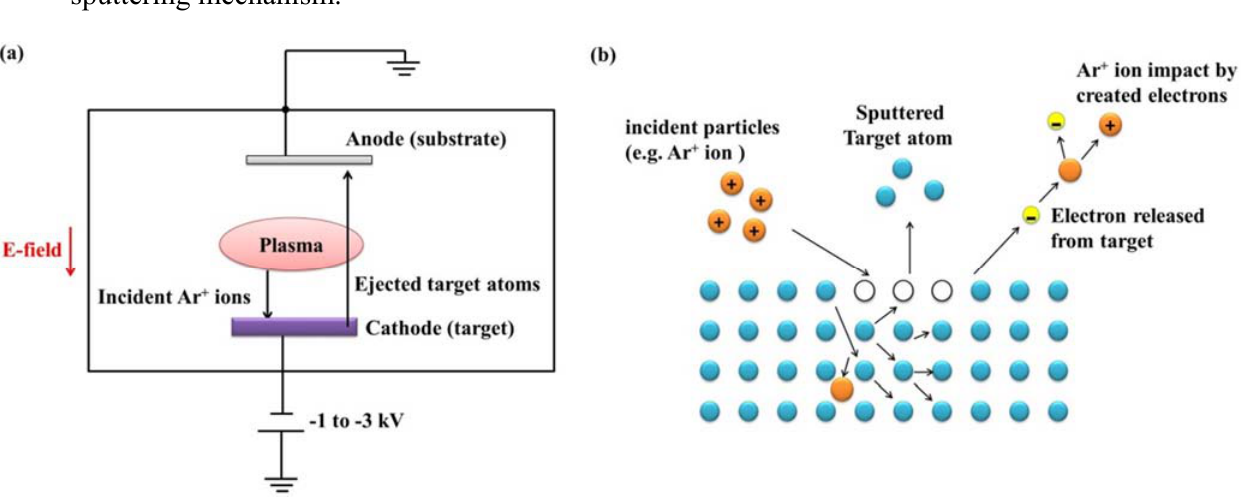
Figure 4. ( a ) Schematic diagram of a basic sputtering system [11]; ( b ) schematic sputtering